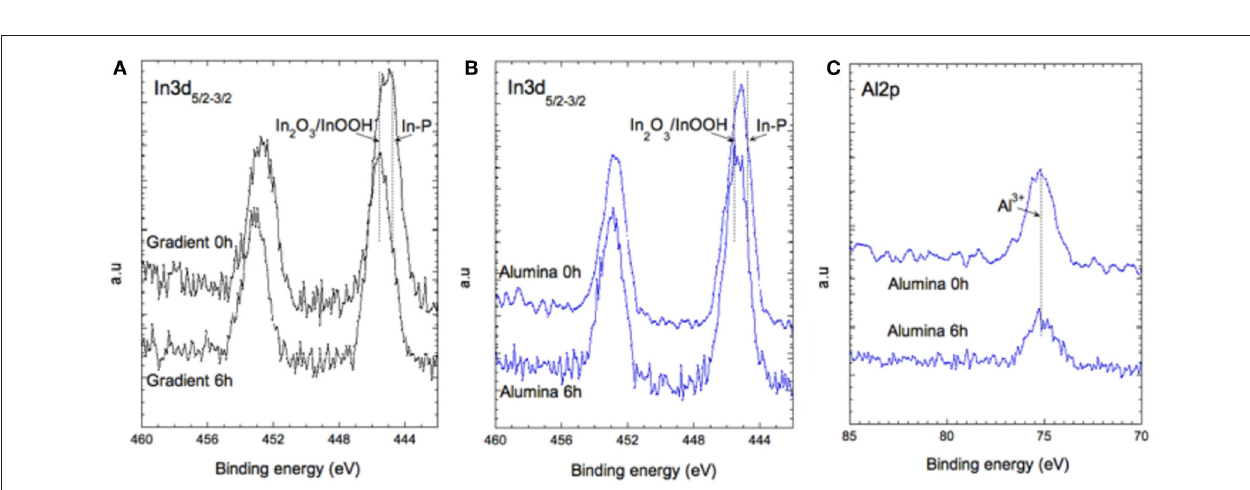
FIGURE 8 | XPS spectra of In 3d for (A) the gradient shell sample and (B) the aluminum treated sample at 0 and 6h of aging. (C) XPS spectra of Al 2p for the aluminum treated